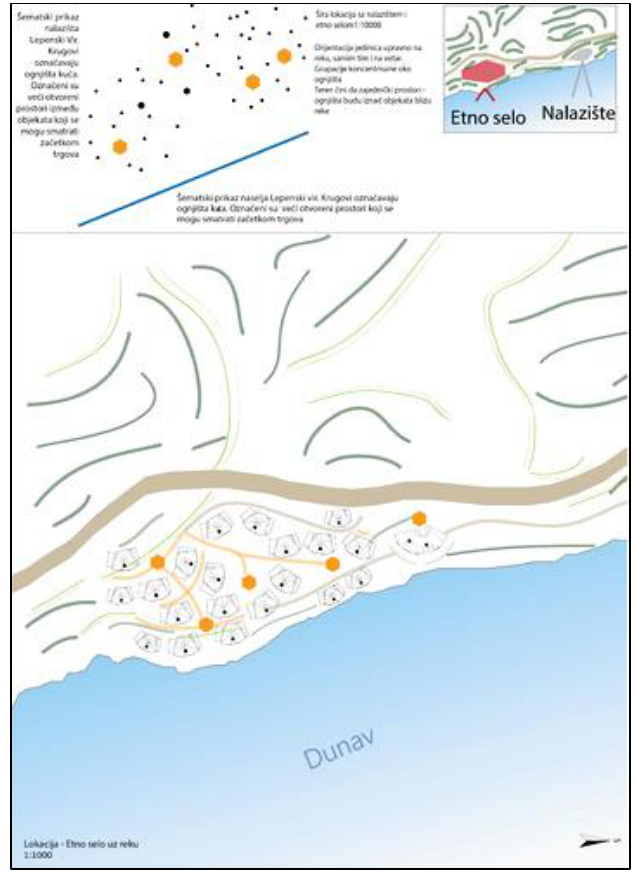
Figure 34. The layout of the Lepenski Vir tourist settlement, according to the pattern and in line with the resolutions of our ancestors. There is one already built communication that connects the settlement with the surrounding territory. The terrain is slightly different from that of the archaeological site. It is slightly more tilted towards the sun, so the microclimate is somewhat better here. But it is still worth taking advantage of what our ancestors left to our heritage. With the help